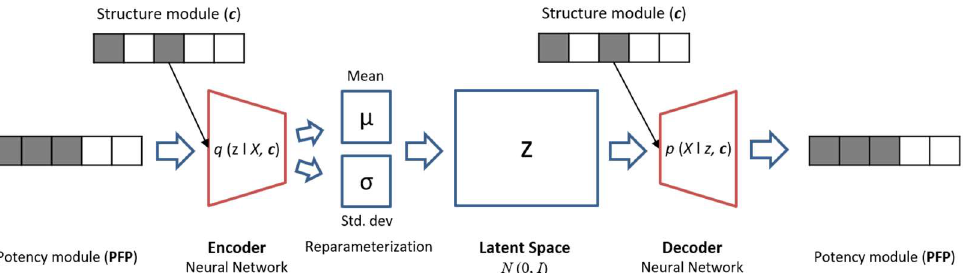
Figure 3. Architecture of the conditional variational autoencoder. The encoder network transforms the potency module (PFP), conditioned by the structure module (c), into a distribution of latent variables (z). The decoder samples a conditioned latent vector from a Gaussian distribution and reconstructs the potency module.